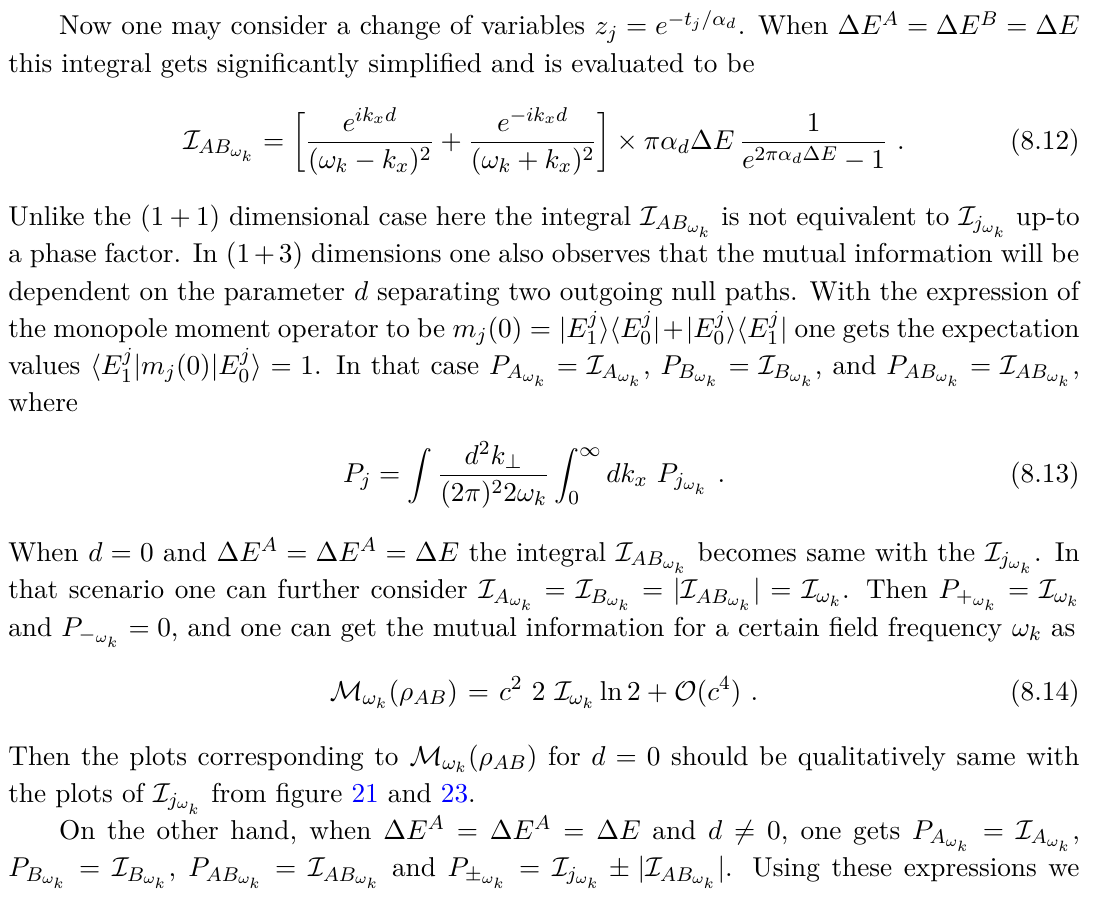
Figure 35 . The mutual information M ω as perceived by two out going null detectors is plotted with respect to the dimensionless transition frequency ∆ E = r ∆ E for fixed dimensionless field mode frequency ω H d/α d = 0